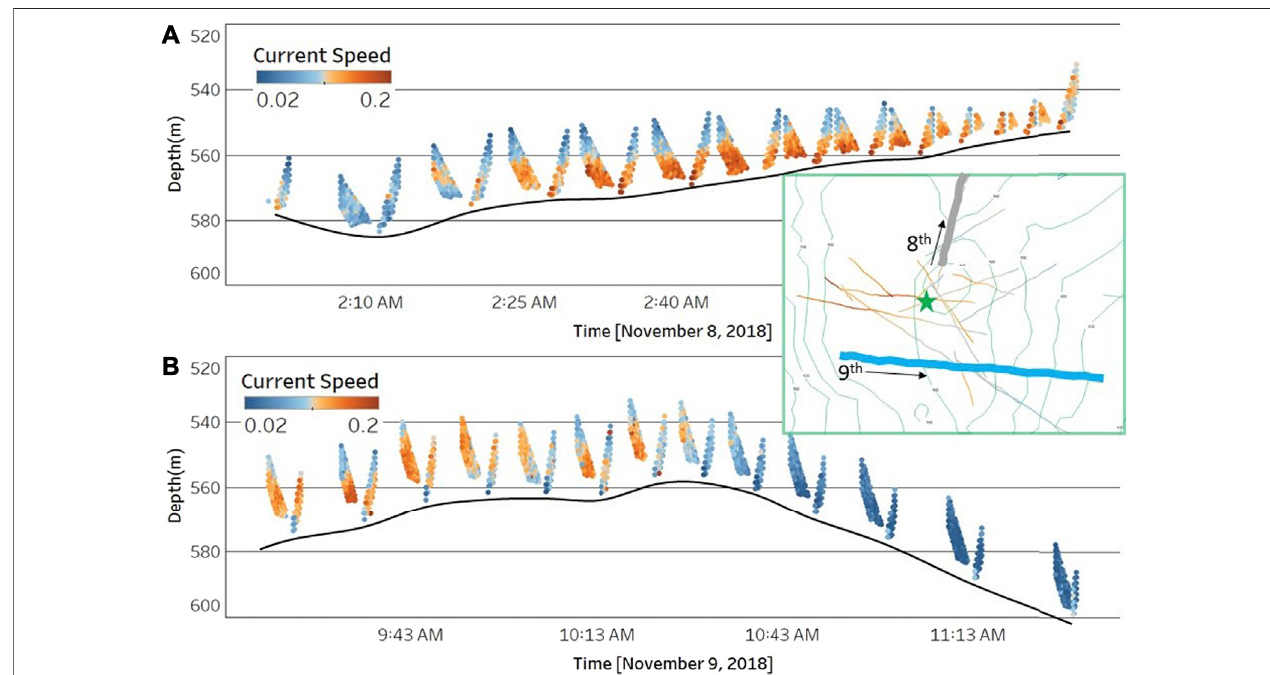
FIGURE13| Detailedon-bottomdatashowingstrongnearbottomcurrents. (A) showsdataforthe8 th ofNovemberand (B) forthe9 th .Thecurrentspeedsshown range from 0.02 to 0.2 m/s and the color scale diverges at 0.11. The horizontal axes indicate time of acquisition for each day. The inset map shows the locations of the traversesrelativetoBushHillandthelocalbathymetry( Figure10 ).Thecurrentdirectionofthe8thispredominatelytotheeastandonthe9thtothesouth( Figure11 )so in both cases the traverse is across the fl ow direction. The pairs of data points are collected on the descent and ascent of each mini-yo.